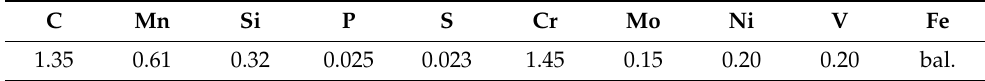
Table 1. Chemical composition of 145Cr6 steel used in the study